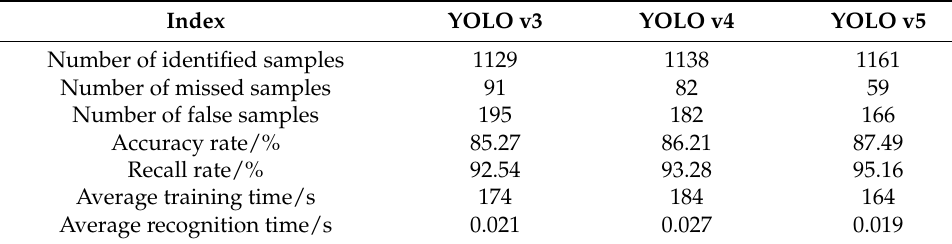
Table 7. Relief hole target recognition results based on YOLO v3, YOLO v4, and YOLO v5.